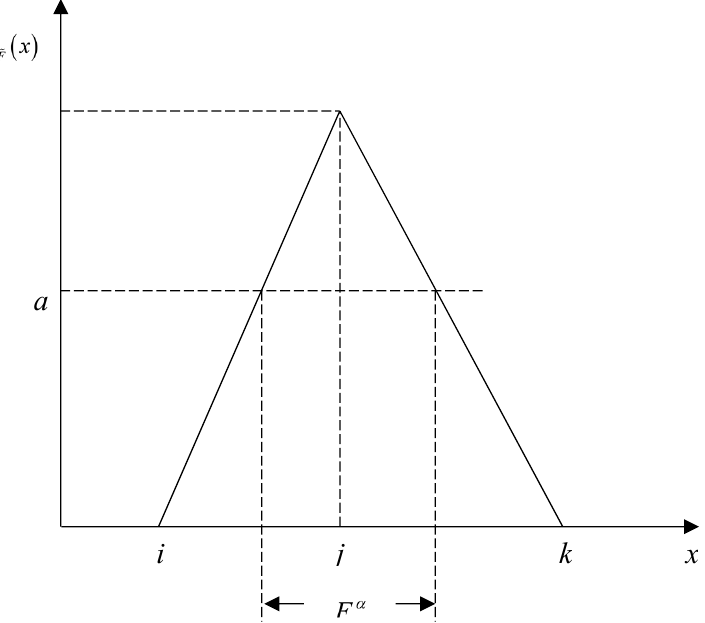
Figure 2. α —cut set of triangular fuzzy number F α α Figure 2. —cut set of triangular fuzzy number F α .